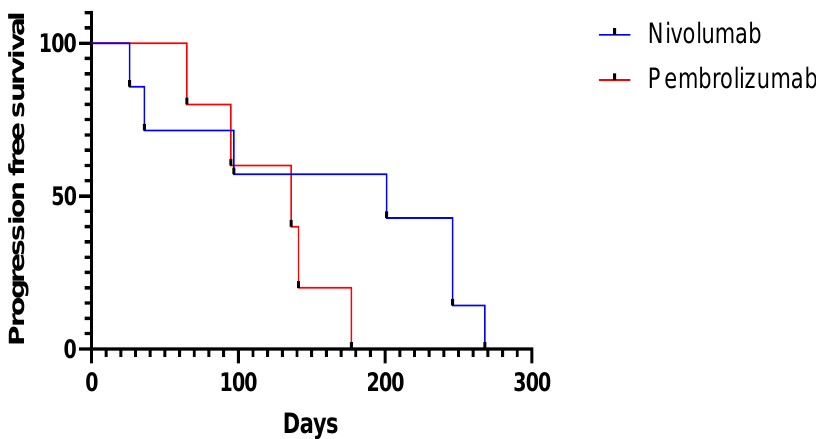
Figure 2. Progression-free survival (nivolumab vs. pembrolizumab) did not illustrate a significant difference ( p = 0.17).